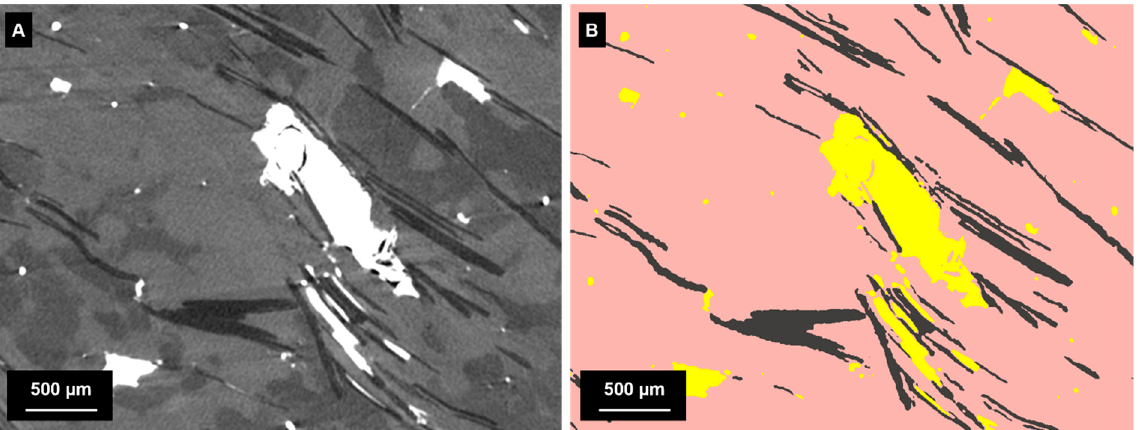
Figure 3. CT volume slice of the scanned specimen before ( A ) and after segmentation ( B ). The col- ours represent the segmented classes: graphite (dark grey), high X-ray absorbing phases (particularly pyrrhotite, pyrite and accessories of zircon) (yellow) and the silicate matrix (pink).